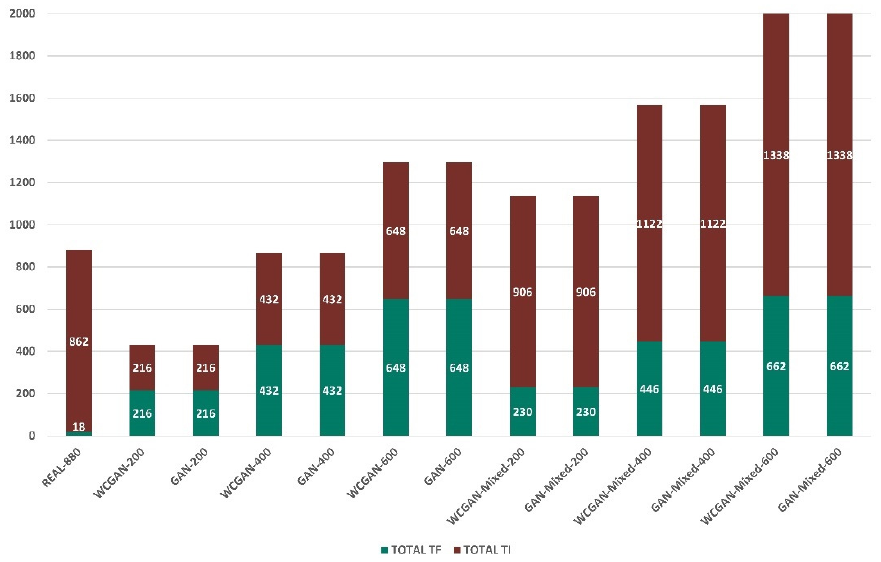
generated samples based on real samples.